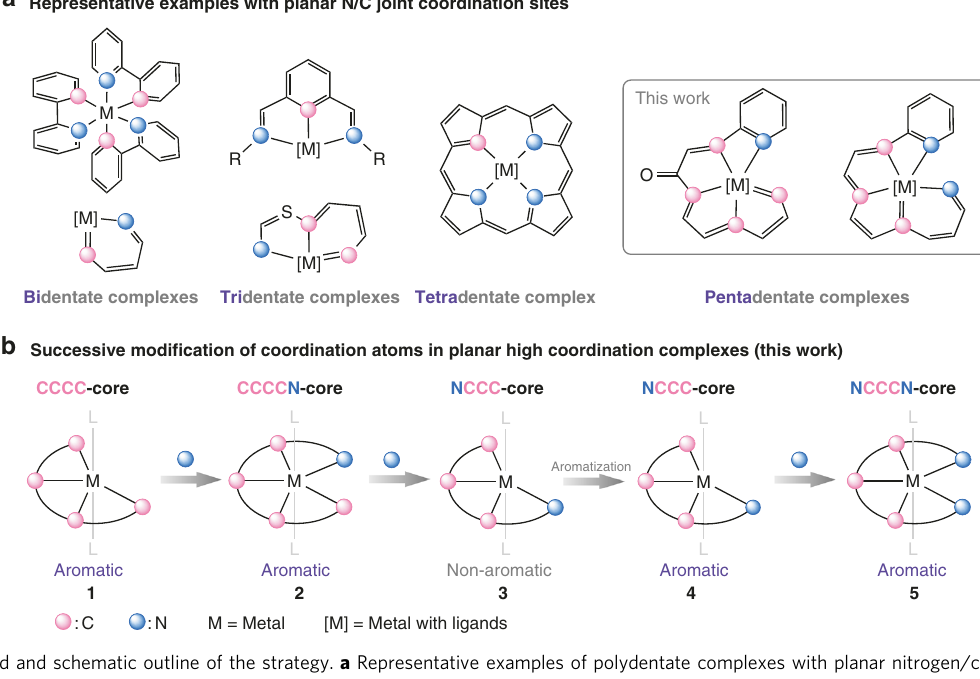
Fig. 1 Background and schematic outline of the strategy. a Representative examples of polydentate complexes with planar nitrogen/carbon (N/C) joint coordination sites. b Successive and direct transformation of coordinating atoms in complexes with a CCCC core via reactions of the metal – carbon bonds to generate planar N/C high-coordinate complexes (this